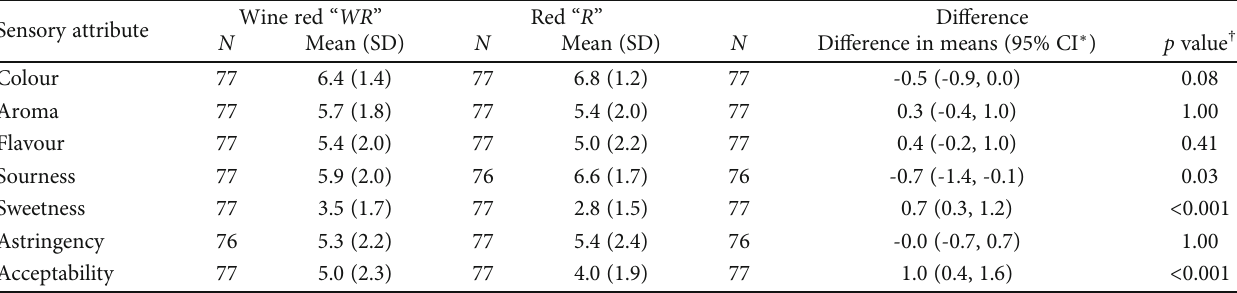
Table 3: Consumer sensory analysis of the two Rubus rosifolius varieties WR and R.